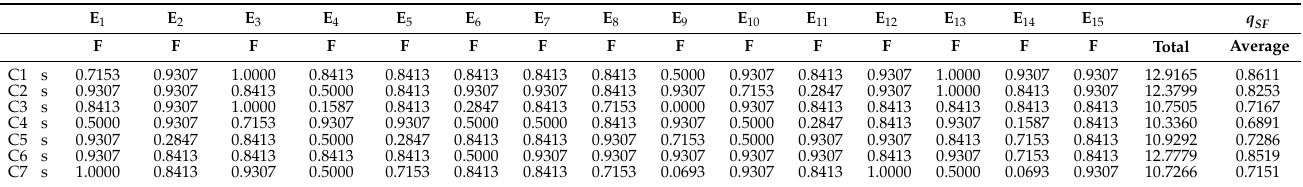
Table 12. Transformed preference weight for possible outcome of “success” in